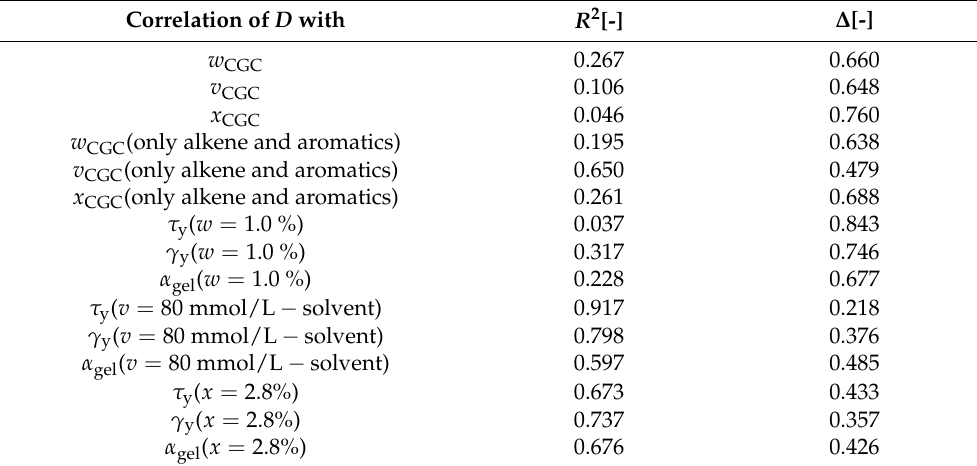
Table 2. Correlation results ( R 2 and ∆ ) between D and various experimental variables. Correlation of D with R 2 [-] ∆ [-] w CGC 0.267 0.660 v CGC w CGC (only alkene and aromatics) v CGC (only alkene and aromatics)